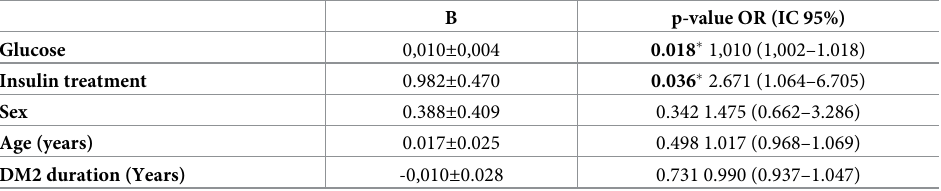
Table 4. Logistic regression model analyzing the influence of rs1544410 genotypes and metabolic variables in patients with